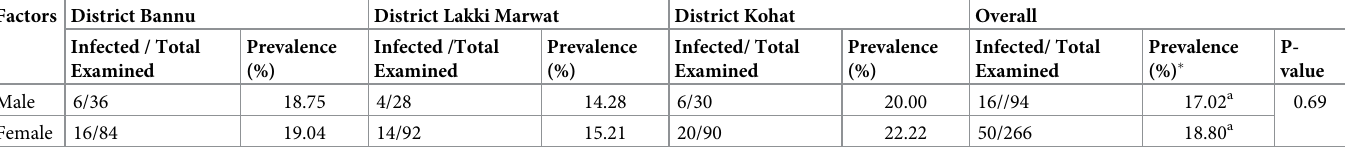
in high mortality in Pakistan. Similarly other countries in Southern Asia are also at risk for the Cryptosporidium infection in small ruminants. The advance diagnostic technique was applied for detection of Cryptosporidium infection such a polymerase chain reaction (PCR). The PCR based finding of the Cryptosporidium infection was more sensitive method than other conven- tional microscopy [21]. The highest prevalence of Cryptosporidium infection was recorded in the summer season while the lowest prevalence was recorded in the winter season. Our results are consistent and agree with the results of other researchers and investigators who reported a strong correlation between the warm and wet seasons with the infection rate. A study [22] documented (17.3%) the highest percent prevalence in the summer season in Mazandaran province of Iran where rainfall was maximum [23]. Some other researchers also reported similar results who also reported maximum prevalence of Cryptosporidium infection in rainy and warm season of the year [24] that reach to the highest point in spring and summer season [25]. The highest percent prevalence was recorded in the summer season due to the reason of high intake of water and increased outdoor activities such as swimming (summer activities) during the summer season in recreational water in the form of community swimming and enhancing the chances for fecal-oral transmission [26]. Similarly adult animals produce a large volume of faeces and thus may be responsible for environmental contamination with Cryptosporidium , spp. as reported by Dessı` et al. [27]. Table 4. Sex wise prevalence of Cryptosporidium infection in sheep by simple